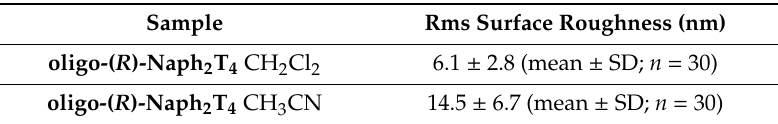
Table 2. Rms surface roughness values (on 500 × 500 nm 2 areas) of the two films ( R )-Naph 2 T